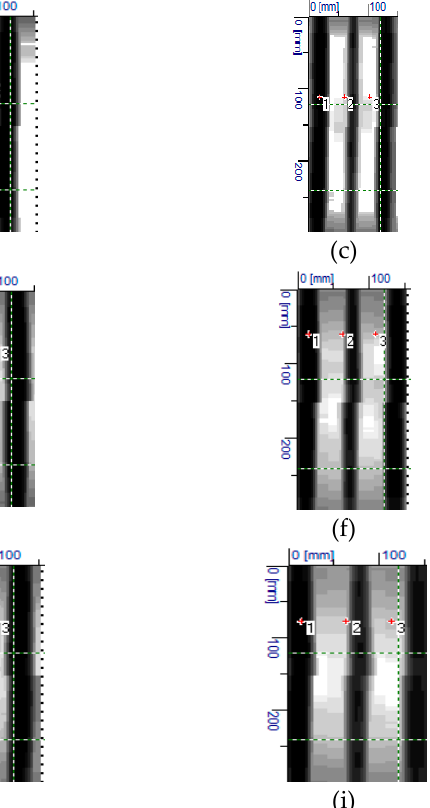
two rebars, ø obs = 8 mm, c obs = 25 mm), ( b ) S-10-30 (three rebars, ø obs = 8 mm, c obs = 20 mm), ( c ) S-10-40